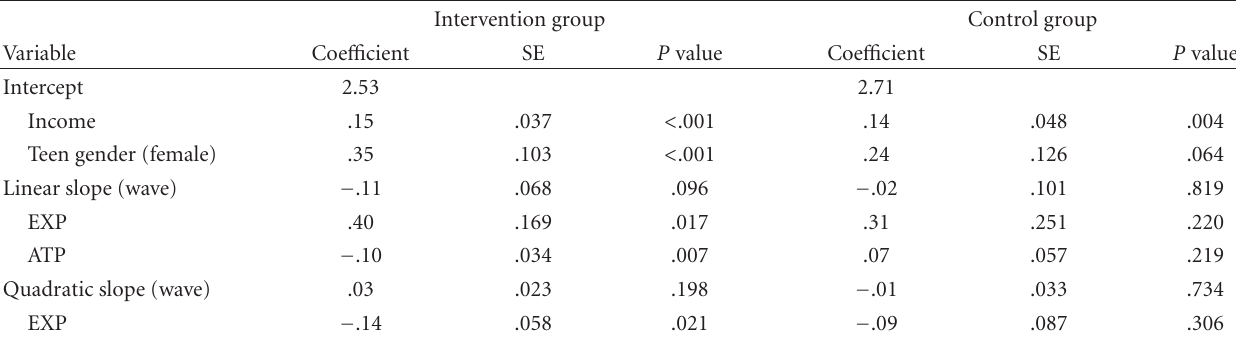
Table 4: Hierarchical linear growth model for teen-reported parental monitoring.